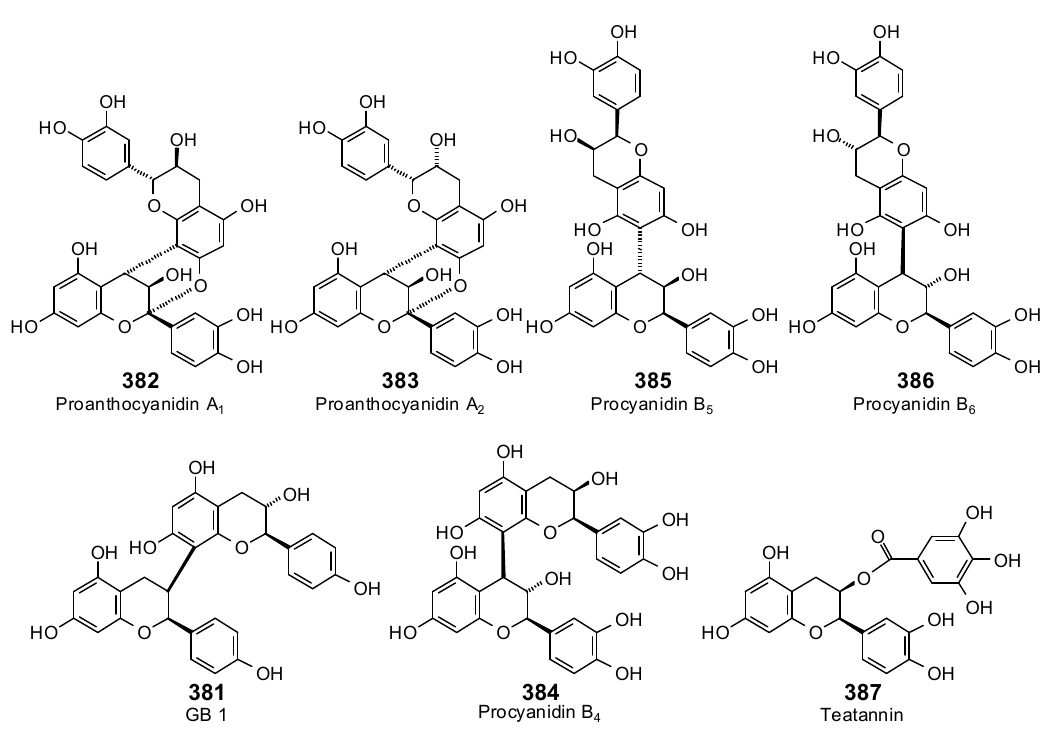
Figure 16. Condensed tannins examined in this work.